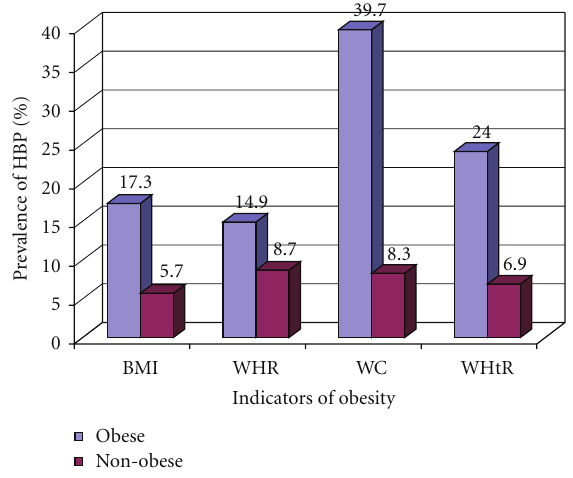
Figure 2: Prevalence of elevated blood pressure in Egyptian adolescents according to di ff erent obesity